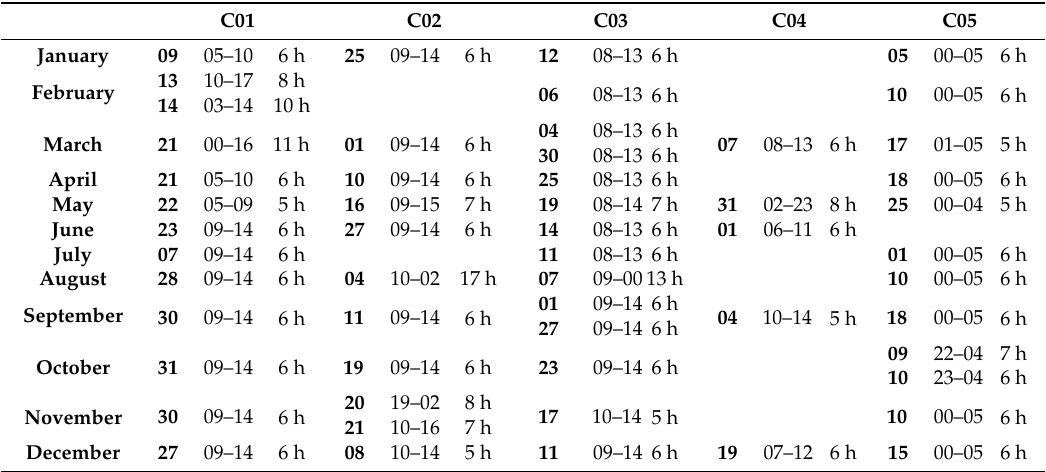
Table 2. Beidou geostationary earth orbit (GEO) satellite maneuver dates and broadcast ephemeris unhealthy periods in